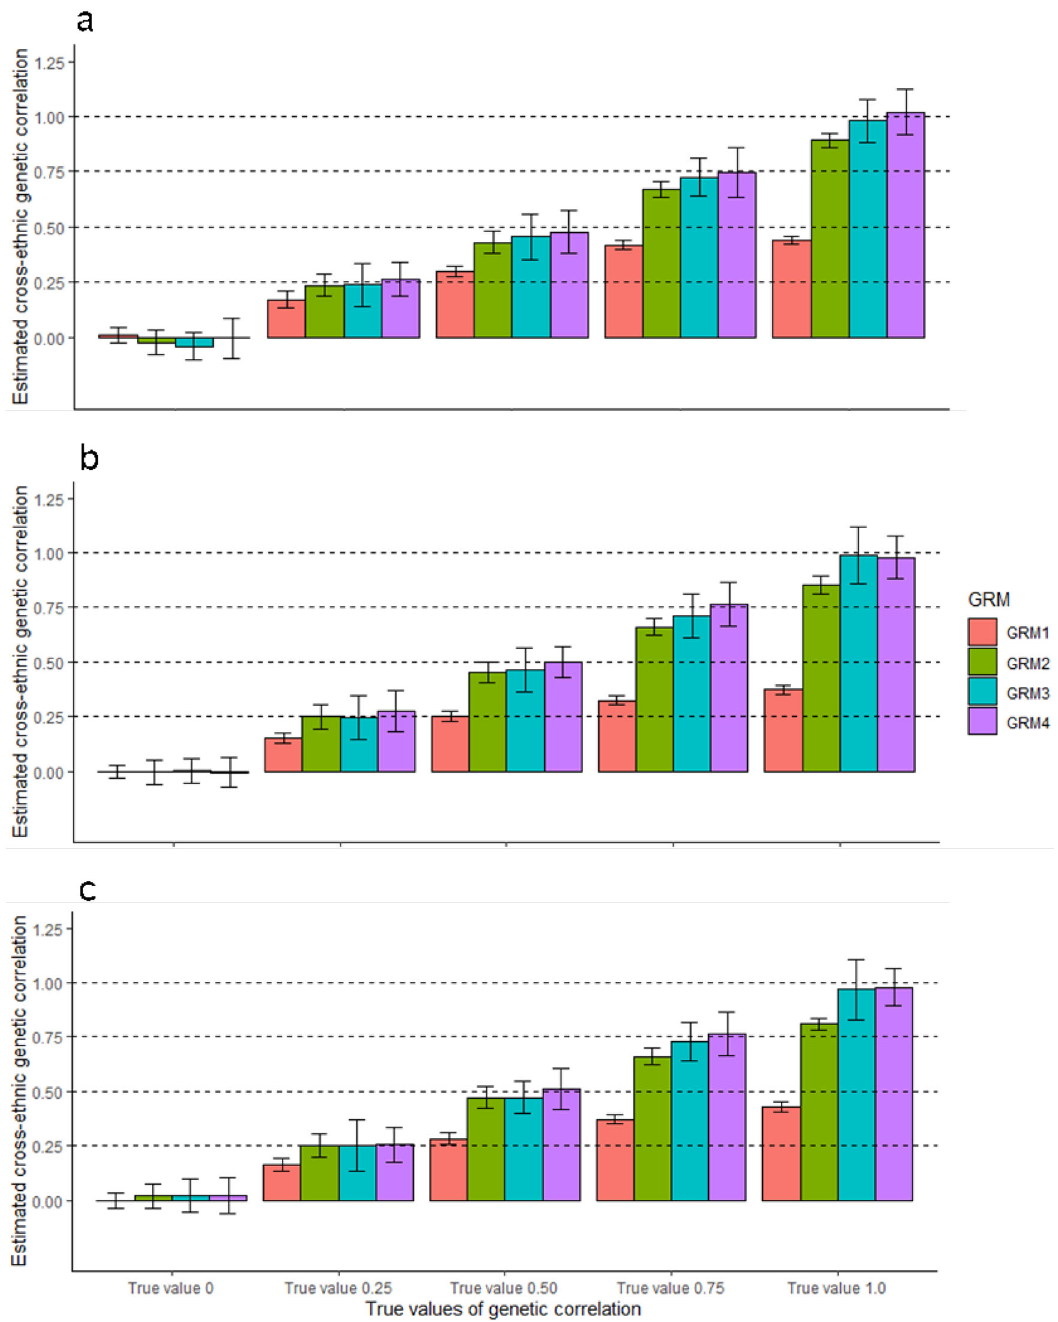
Fig. 2 | Estimated cross-ancestry genetic correlations from four existing methods when α is fi xed to − 0.5 for both simulation and estimation. The main bars represent the averages of estimated cross-ancestry genetic correlations, and the error bars indicate 95% con fi dence interval (CI) of the averages, which are derived from 500 experimental replicates that were independently carried out. In our simulations, weused three combinations for estimating cross-ancestrygenetic correlation, i.e., a White British vs. South Asian, b White British vs. African and c South Asian vs. African ancestry cohorts. In each ancestry group, we used 500,000 SNPs that were randomly selected from HapMap3 SNPs after QC. To simulate phenotypes, we selected a random set of 1000 SNPs as causal variants, whichwerepresentedforbothancestrygroups.Weused α = − 0.5whenscalingthe